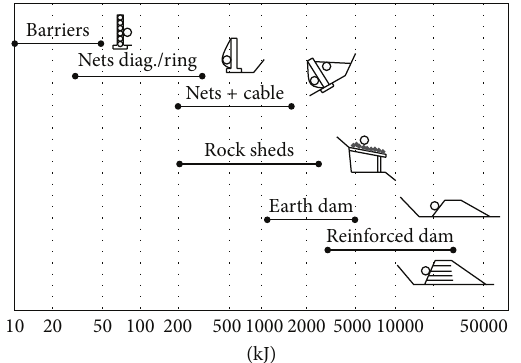
Figure 1: Energy absorption capacity of different rockfall protection structure.